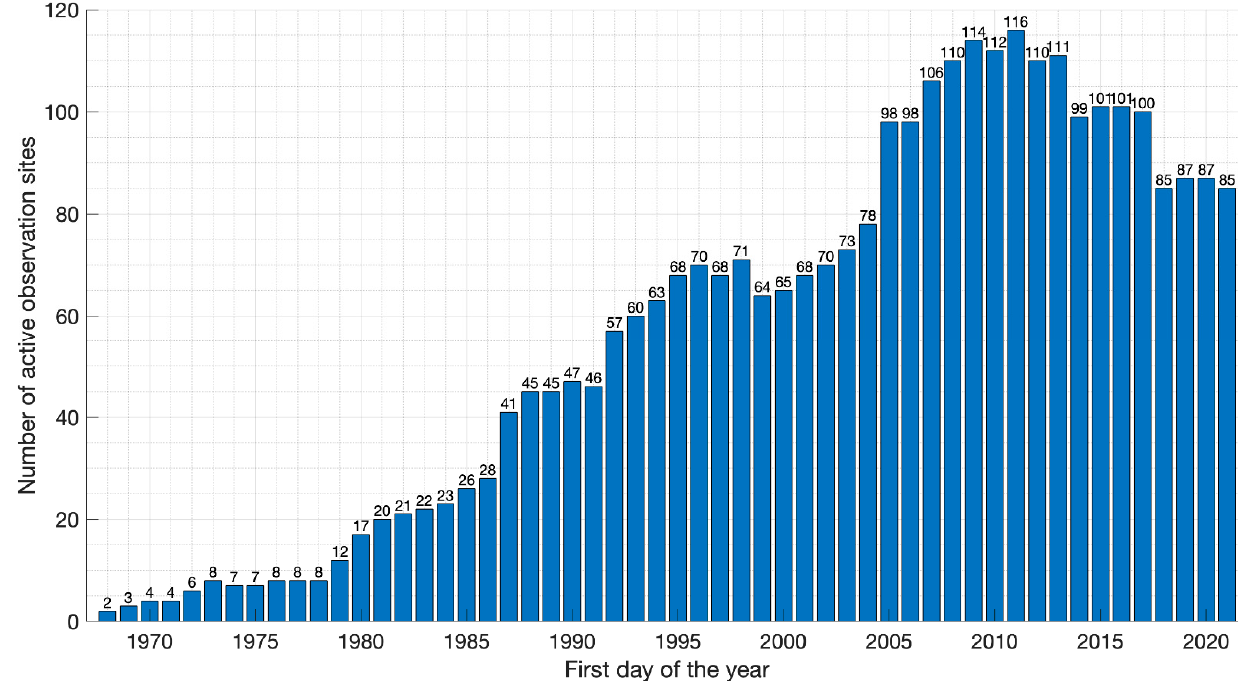
Figure A1. The number of active observation sites at the beginning of each year. Data elaborated from the information reported in Table A3 in the Appendix.